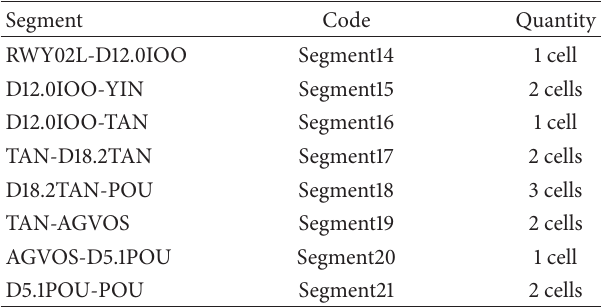
Table 2: Cell quantities of departure routes to RWY02L